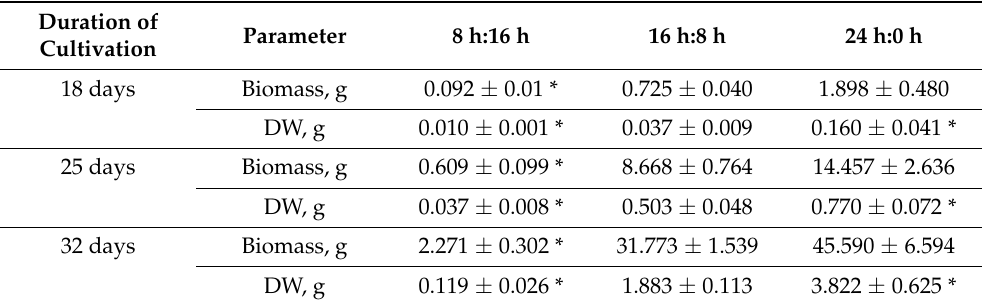
Table 1. Biomass and dry weight (DW) of shoots in plants after 18, 25, and 32 days of cultivation ( n = 6). “8 h:16 h” is 8 h (light):16 h (dark), “16 h:8 h” is 16 h (light):8 h (dark), and “24 h:0 h” is 24 h (light):0 h (dark). Duration of Parameter 8 h:16 h 16 h:8 h 24 h:0 Cultivation